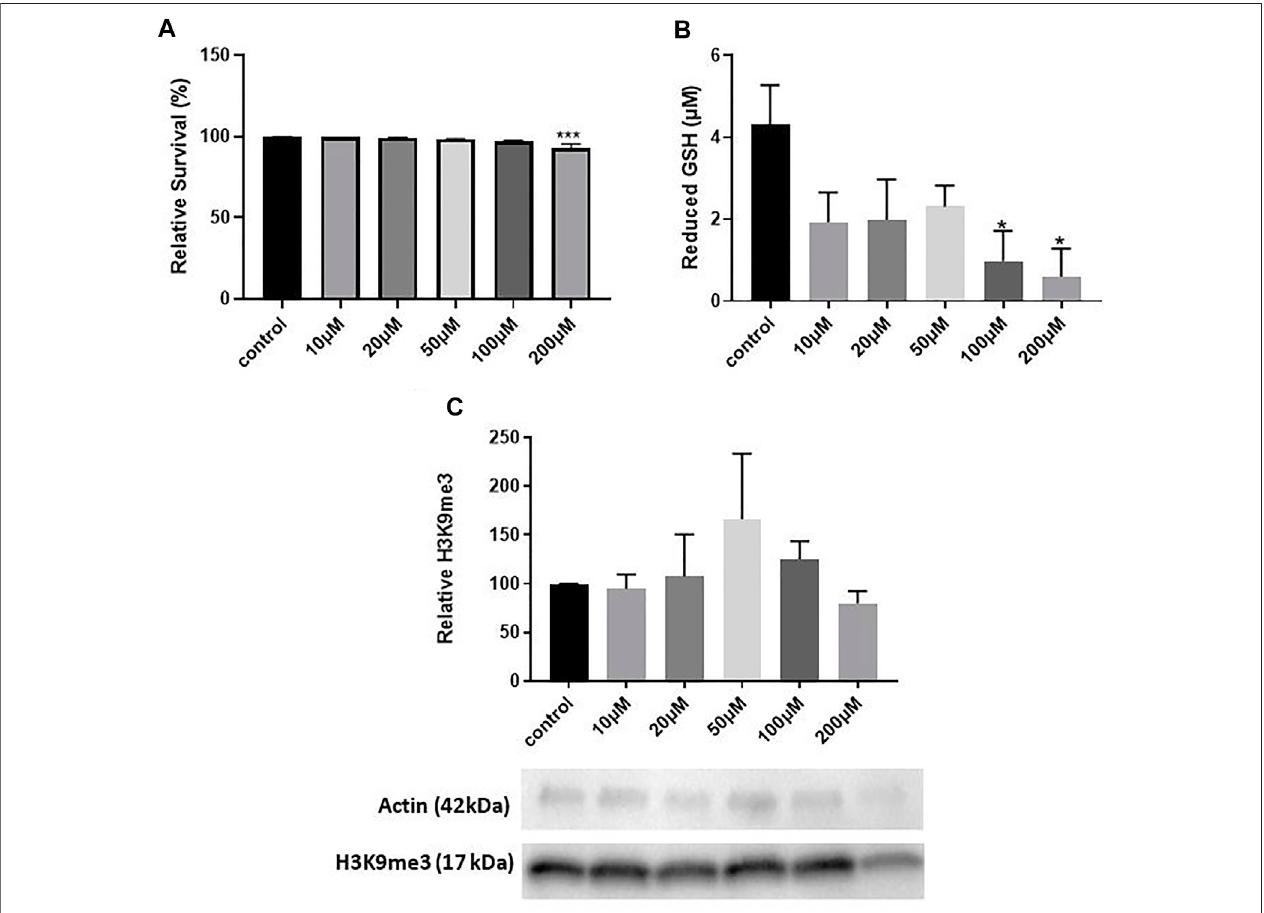
FIGURE1| TheAge-AssociatedStressorH2O2DoesNotInduceRepressiveHistoneMethylationin12DIVHippocampalNeurons. (A) LDHassayquanti fi cationof toxicityin12DIVhippocampalneuronculturestreatedwith10 – 200 μ MH2O2.One-wayANOVA,*** p =0.0025, n =4.Dunnet ’ smultiplecomparisonstest,*** p =0.0010 controlvs.200 μ M. (B) Glutathioneassayfor12DIVhippocampalneuronculturestreatedwith10 – 200 μ MH2O2.OnewayANOVA,* p =0.041, n =4.Dunnett ’ smultiple comparisons test,* p = 0.02 100 μ M vs. control, * p = 0.012 200 μ M vs. control. (C) Quanti fi cation of H3K9me3 in 12 DIV hippocampal neuron cultures. One way ANOVA, n = 4, p = 0.68. All cultures were treated with H2O2 for 5 min and harvested 8 h later.